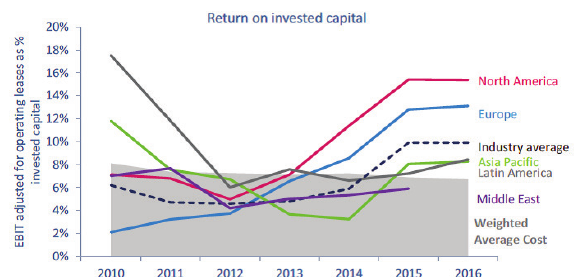
Figure 3. Return of financial resources invested into civil aviation development